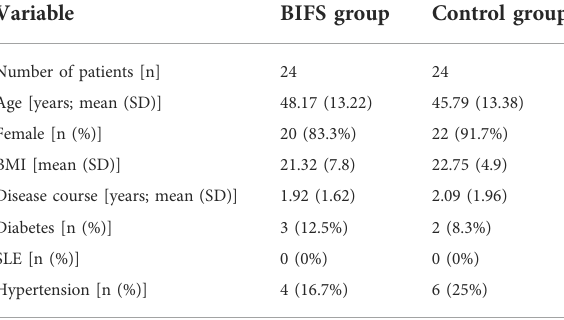
TABLE 2 Baseline characteristics of two patient